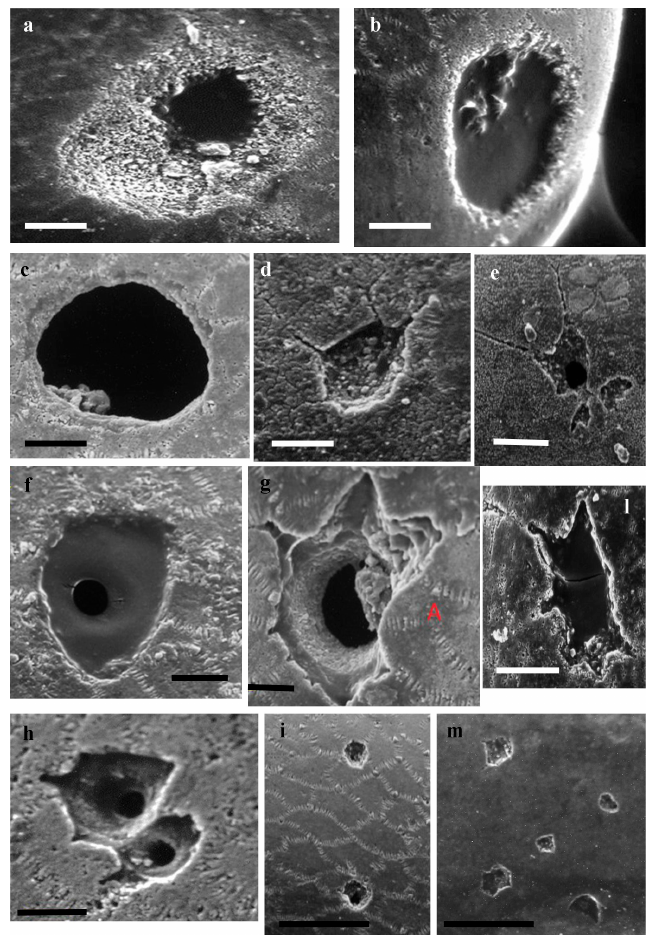
Fig Figure 6. Examples of microborings. ( a ) Oichnus paraboloides, scale bar = 50 µ m. ( b ) Oichnus simplex (not penetrative), scale bar = 50 μ m. ( c ) Oichnus gradatus , scale bar = 50 μ m. ( d ) Failed penetration with traces of rasping, scale bar = 50 μ m. ( e ) Oichnus gradatus with traces of rasping and, in the lower (not penetrative), scale bar = 50 µ m. ( c ) Oichnus gradatus , scale bar = 50 µ m. ( d ) Failed penetration right corner, of a special teeth of radular apparatus, scale bar = 50 μ m. ( f ) Oichnus simplex (partly with traces of rasping, scale bar = 50 µ m. ( e ) Oichnus gradatus with traces of rasping and, in the penetrative), scale bar = 50 μ m. ( g ) Oichnus paraboloides , scale bar = 50 μ m. ( h ) Dipatulichnus rotundus, lower right corner, of a special teeth of radular apparatus, scale bar = 50 µ m. ( f ) Oichnus simplex scale bar = 50 μ m. ( i ) Two holes of Oichnus gradatus, scale bar = 100 μ m. ( l ) Oichnus cf. ovalis with (partly penetrative), scale bar = 50 µ m. ( g ) Oichnus paraboloides , scale bar = 50 µ m. ( h ) Dipatulichnus traces of rasping around the scars, scale bar = 50 μ m. ( m ) Scars with polygonal outlines (possible rotundus, scale bar = 50 µ m. ( i ) Two holes of Oichnus gradatus, scale bar = 100 µ m. ( l ) Oichnus cf. anchorage traces?), scale bar = 100 μ m. ovalis with traces of rasping around the scars, scale bar = 50 µ m. ( m ) Scars with polygonal outlines (possible anchorage traces?), scale bar = 100 µ m.